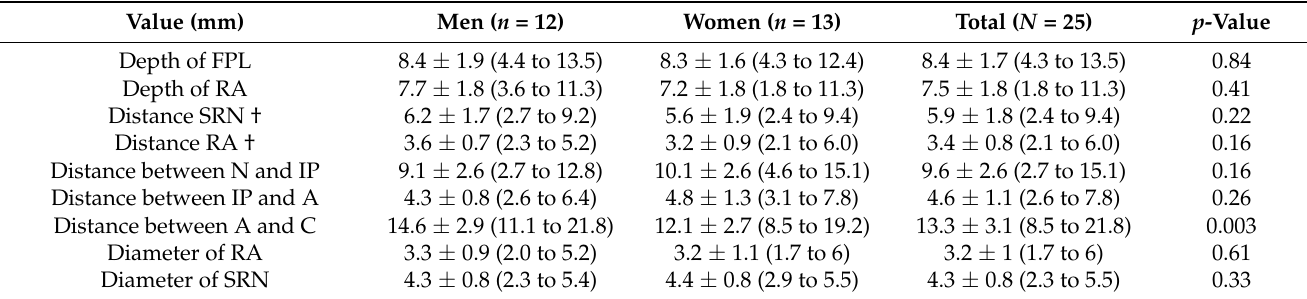
Table 2. Ultrasonographic parameters at the distal third of forearm ( n =